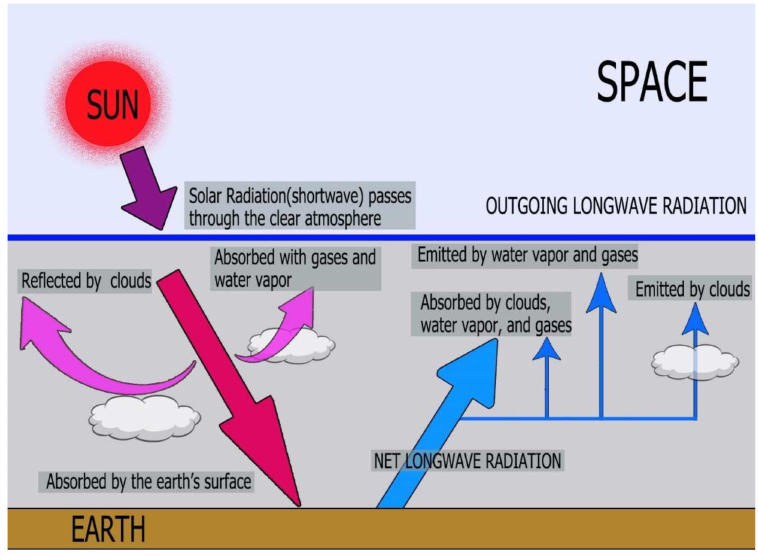
Figure 12. The process of energy and moisture exchange and transmission between the land and the